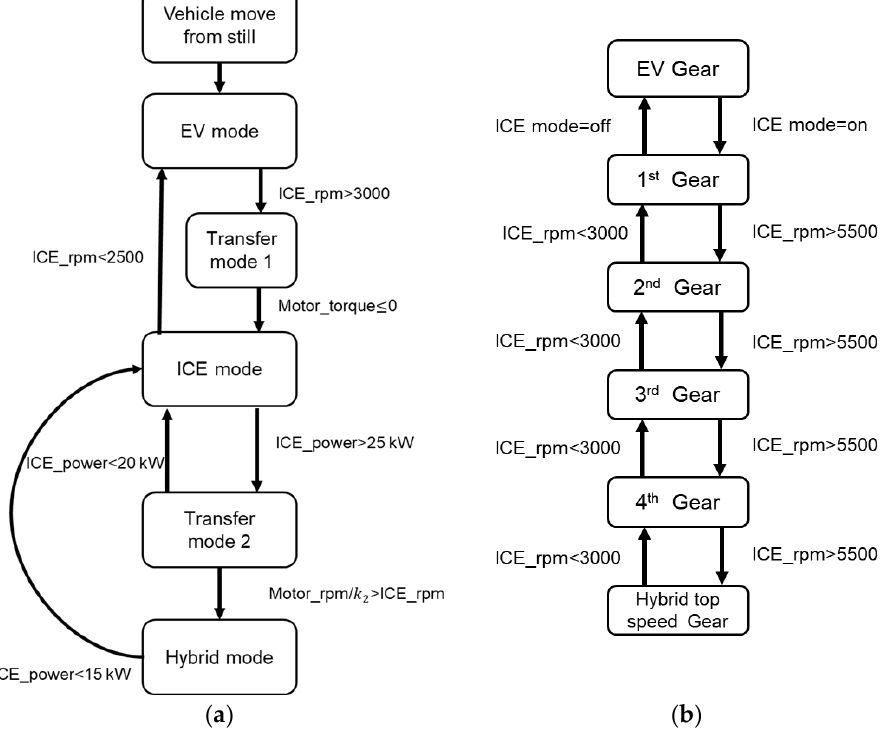
Figure 11. ( a ) Driving mode control logic. ( b ) Gear shifting control logic.